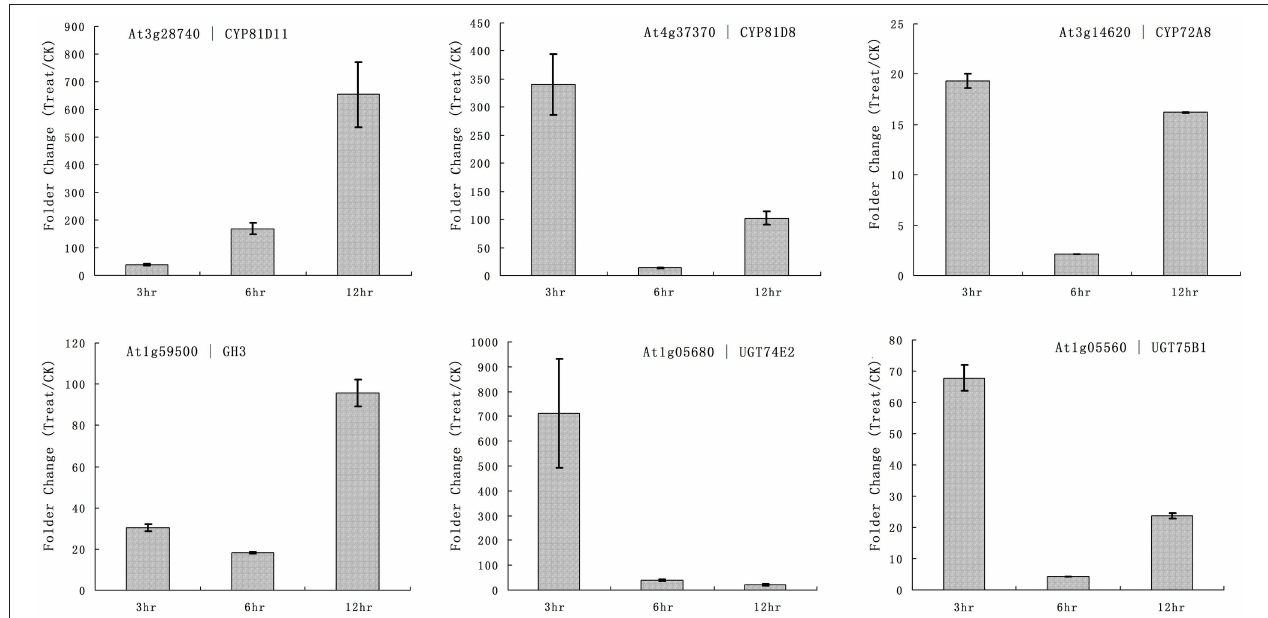
FIGURE 6 | The expression pattern of selected Arabidopsis genes responded to different times of quinclorac treatment. The expression values were detected by real-time RT-PCR. The gray bars indicated the fold change of the gene between quinclorac treatment and mock; the error bars represent the standard error of three replicates. At3g28740—CYP81D11; At4g37370—CYP81D8; At3g14620—CYP72A8; At1g59500—GH3; At1g05680—UGT74E2;